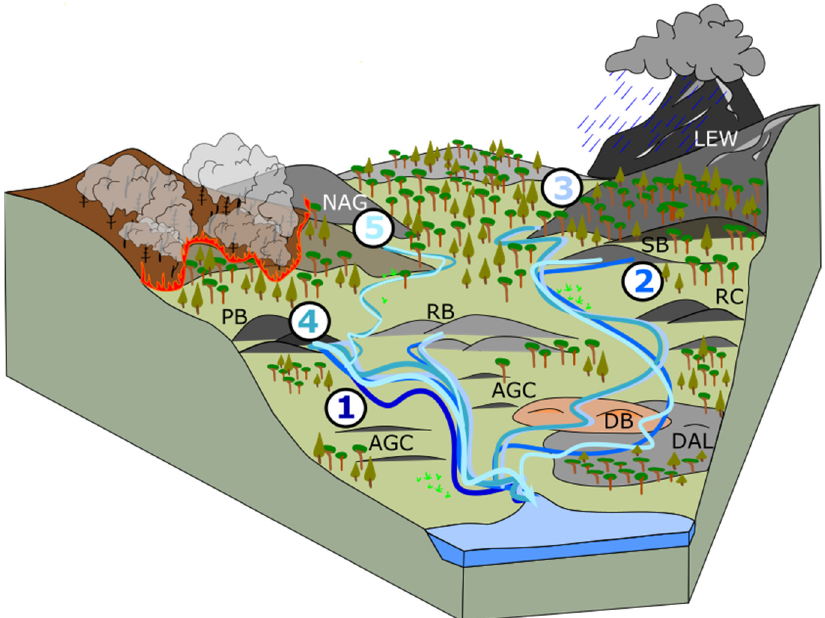
Figure 10. Schematic paleoenvironmental reconstruction of the hinterland sourced by the Mullagh- more Sandstone Formation fluvial system during the Viséan. Various channel-flow regimes are marked 1–5 corresponding to the channelised units sampled. The view is looking northwestward.